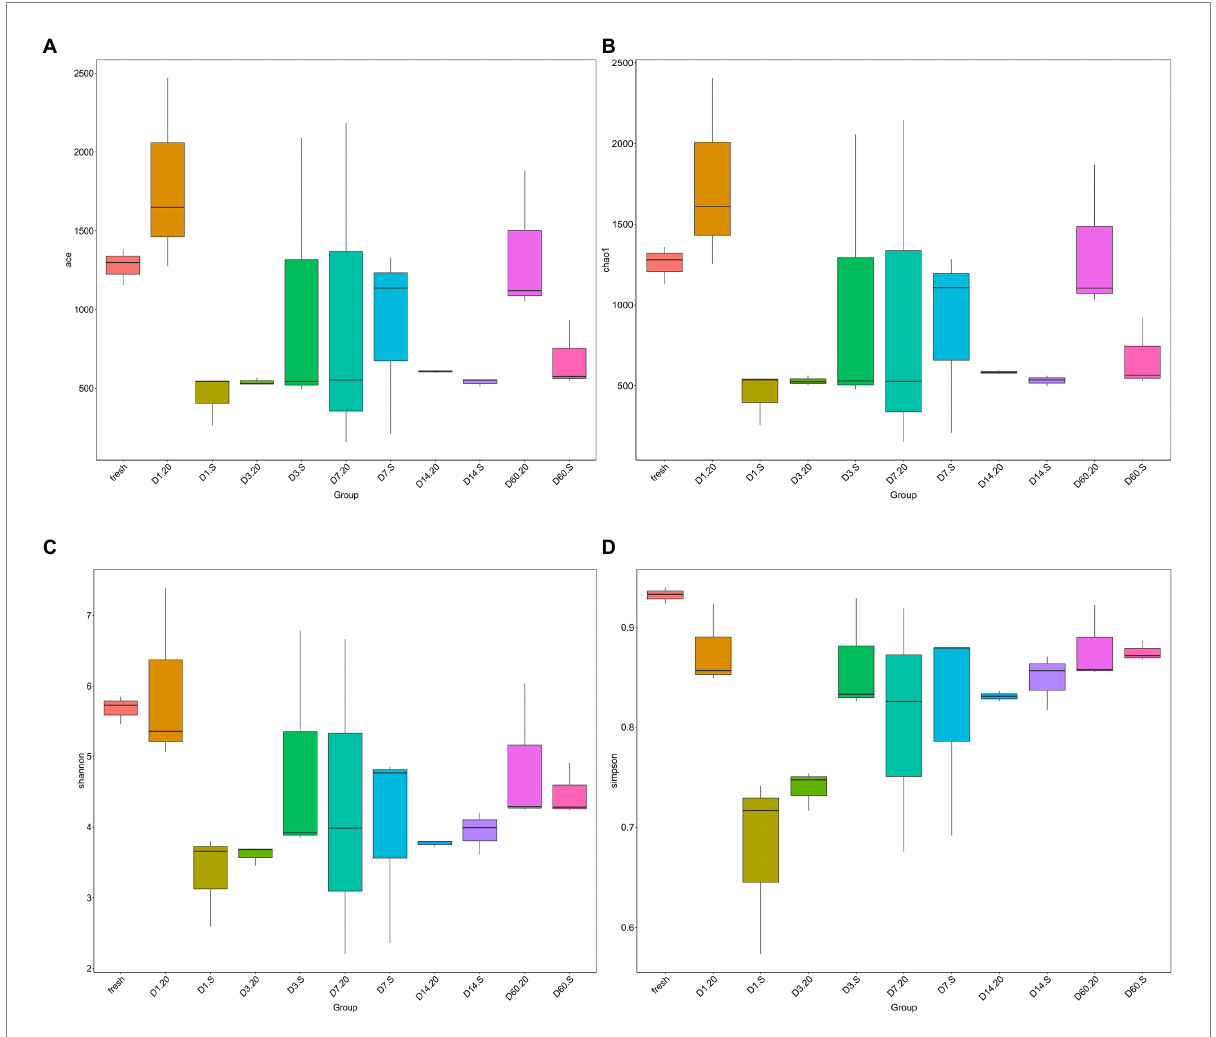
FIGURE 5 Alpha diversities of bacterial community in samples evaluated via ACE (A) , Chao1 (B) , Shannon (C) , and Simpson (D) indexes. 20, constant temperature of 20 ° C; and S, freeze–thaw condition, alternating 20 and − 5 ° C every 12